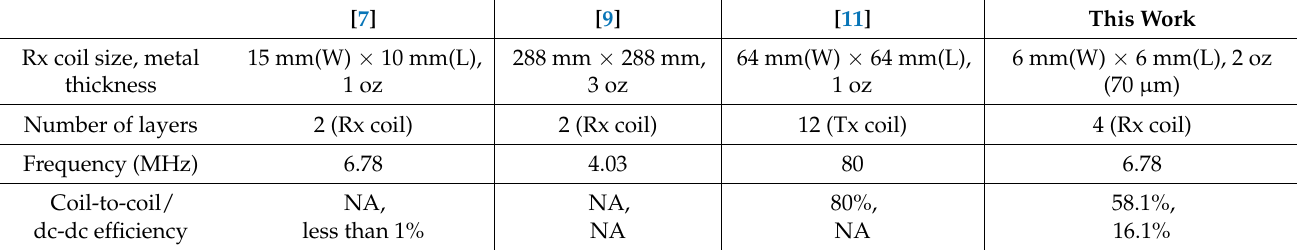
Table 2. Comparison between previous works and this work.